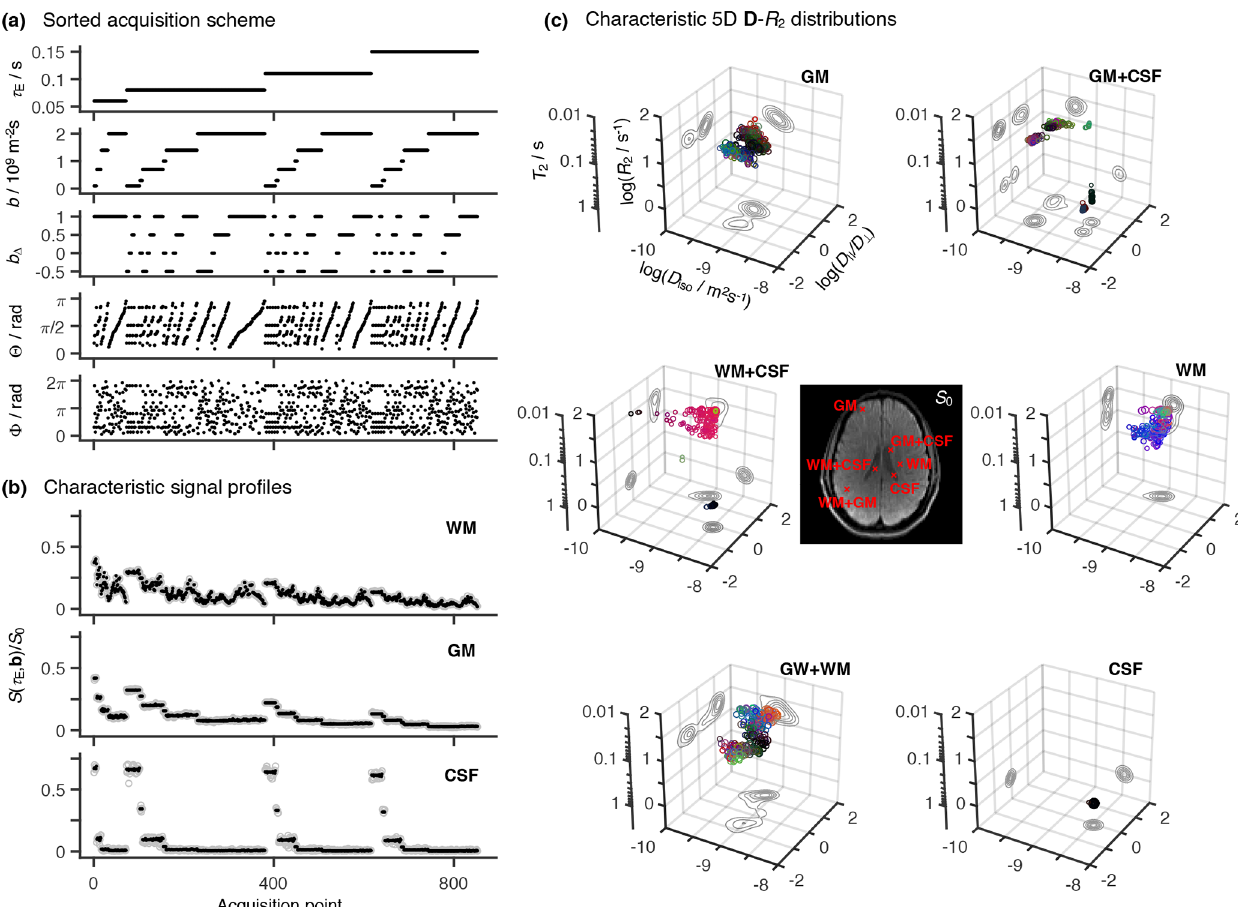
Figure 2. Representative 5D relaxation–diffusion encoded signals S ( τ E , b ) and distributions P ( R 2 , D ) for selected voxels in a living human brain. (a) Acquisition scheme showing τ E , b , b (cid:49) , (cid:50) , and (cid:56) as a function of acquisition point. (b) Experimental (gray circles) and fitted (black points) S ( τ E , b ) signals from three representative voxels containing white matter (WM), gray matter (GM), and cerebrospinal fluid (CSF). The presented signal data were acquired according to the scheme shown in panel (a) and is drawn with the same horizontal axis. (c) Nonparametric R 2 - D distributions obtained for both pure (WM, GM, CSF) and mixed (WM + GM, WM + CSF, GM + CSF) voxels. The discrete distributions are reported as scatter plots in a 3D space of the logarithms of the transverse relaxation rate R 2 , isotropic diffusivity D iso , and axial–radial diffusivity ratio D || /D ⊥ . An auxiliary relaxation time T 2 scale was included along the log( R 2 ) axis to aid the inspection of the P ( R 2 , D ) plots. The diffusion tensor orientation ( θ , ϕ ) is color-coded as [R,G,B] = [ cos ϕ sin θ, sin ϕ sin θ, cos θ ]·| D || − D ⊥ | / max( D || ,D ⊥ ), and the circle area is proportional to the statistical weight of the corresponding component. The contour lines on the sides of the plots represent projections of the 5D P ( R 2 , D ) distribution onto the respective 2D planes. Panels (b) and (c) display the signals S ( τ E , b ) and corresponding P ( R 2 , D ), respectively, for the same WM, GM, and CSF